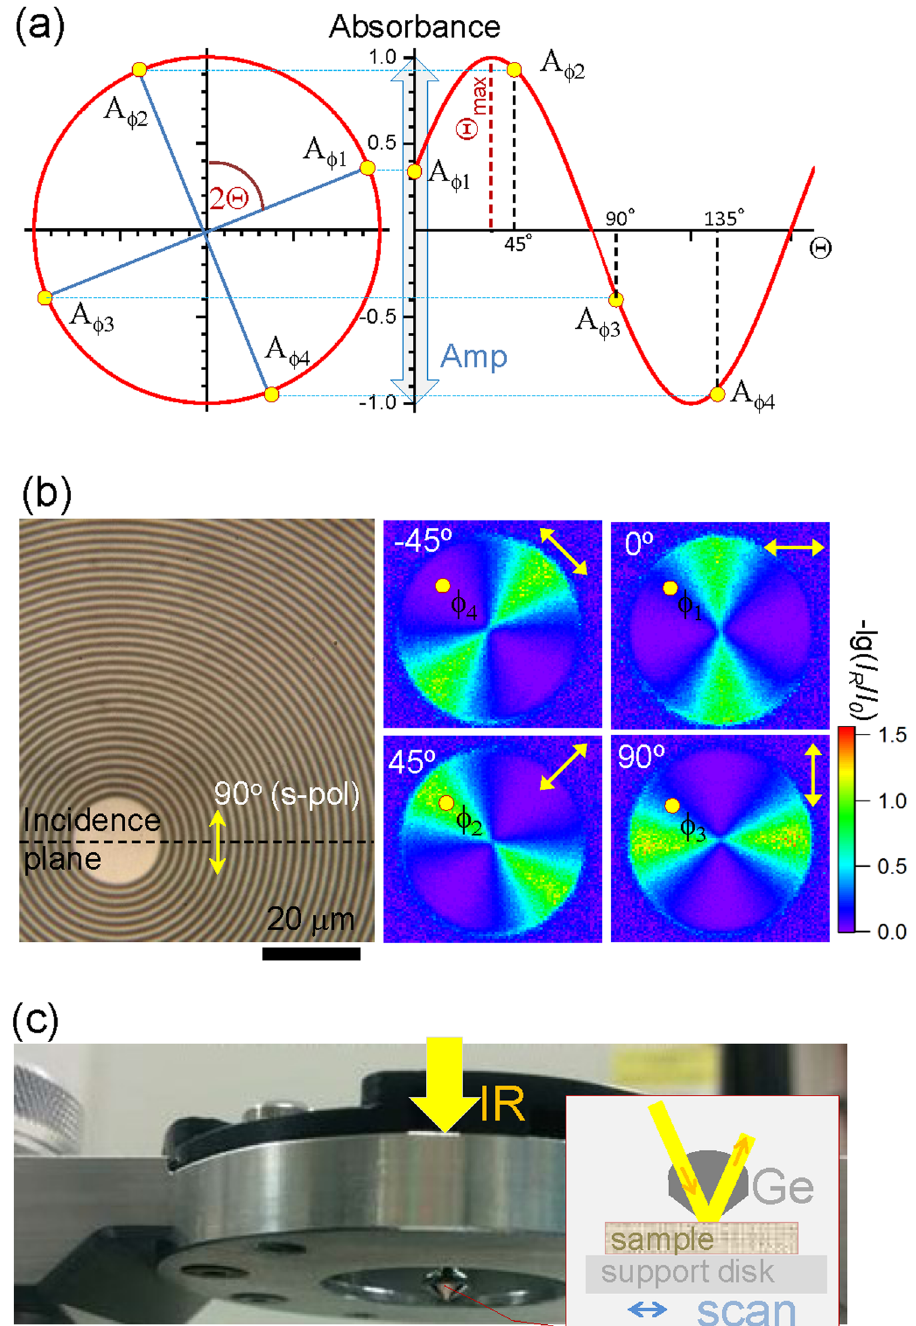
Figure 2. ( a ) Four-polarisation method in IR absorbance at different polarisation azimuths, A = f ( Θ ) 32 , which was used to determine the orientational anisotropy in far-field FT-IR measurements. ( b ) An optical image of a concentric 2- μ m-period Au grating (with a duty cycle of 0.5) on a cover glass used for reflection FT-IR imaging carried out with a Cassegrainian objective lens with a focusing cone over a 17-to − 30° range; dashed-line marks the top-view of the incidence plane. The diameter of the circular grating was 0.5 mm. Four reflection maps for a linearly polarised incidence at the specified polarisation angle (schematically also marked by arrows) at 1500 cm − 1 (~6.7 μ m) wavelength (Spotlight, PerkinElmer); I R ,0 are the reflected and incidence intensities, respectively. ( c ) In-house developed ATR accessory for Hyperion 2000, Bruker microscope. Inset shows schematic illustration of optical geometry used in the ATR FT-IR measurement with a 100- μ m diameter Ge tip (refractive index n =